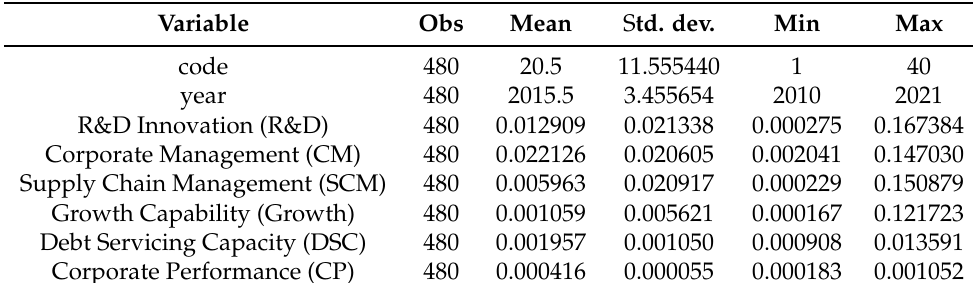
Table 1. Descriptive statistics of variable